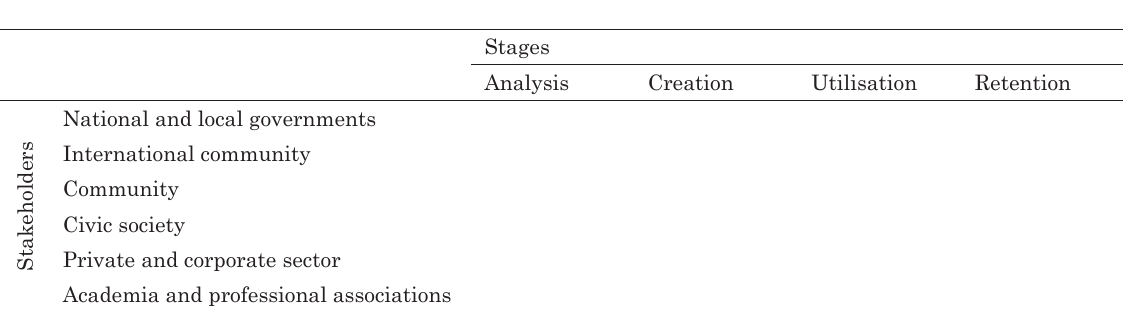
figure 1. capacity development